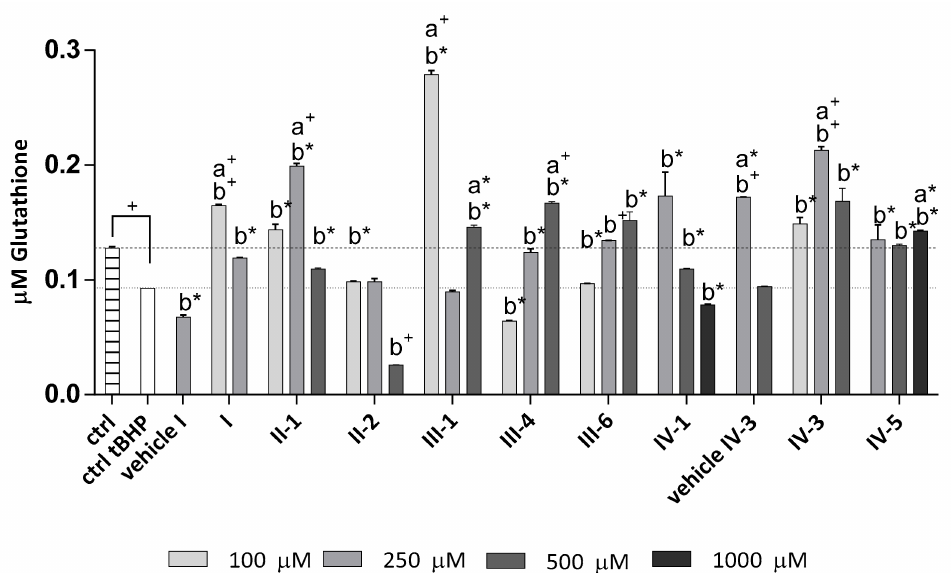
Figure 6. Concentration of total glutathione in cell lysates after 24-h treatment with DHPs followed by 1-h exposure to mild oxidative stress (50 µ M tBHP). Statistically significant difference between DHPs and (a) non-treated control (ctrl (dashed line); only for the significant increase) or (b) treated control (ctrl tBHP (dotted line)) is given as follows: a*/b* p < 0.05; a + /b + p < 0.005 with the difference between ctrl vs. ctrl tBHP as + p < 0.005. Values are given as mean ± standard deviation, n =